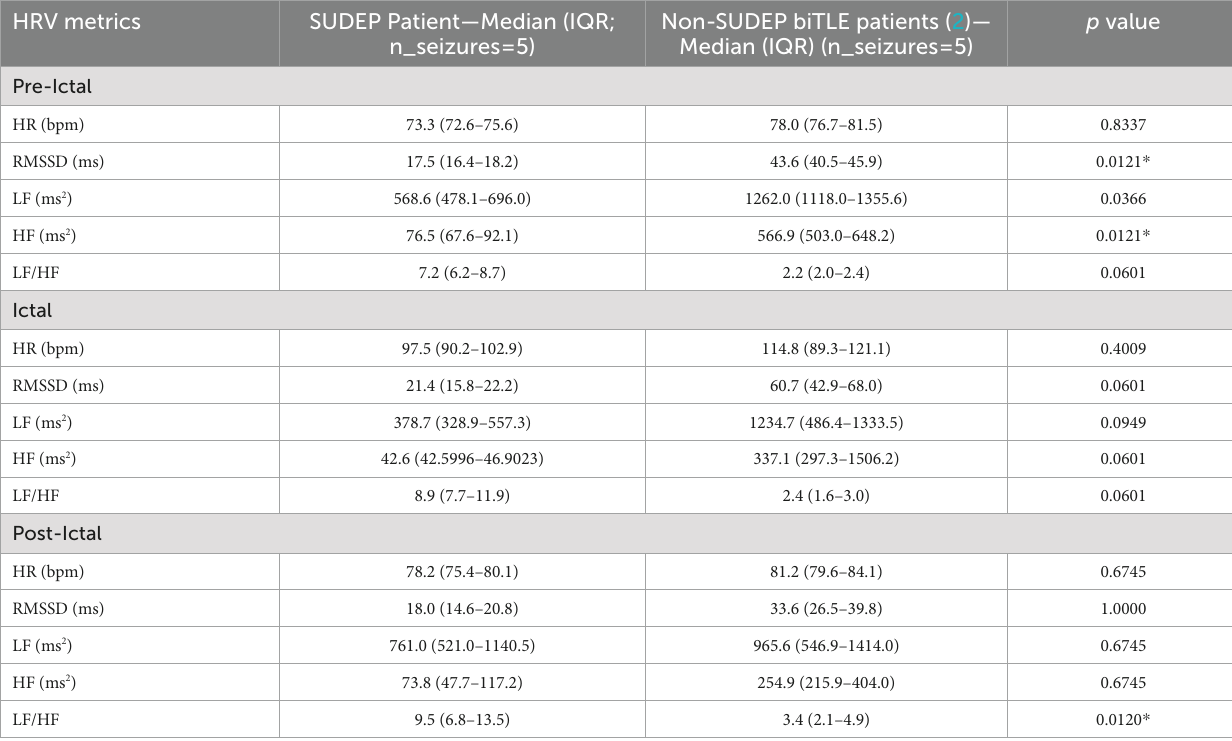
TABLE 2 Peri-ictal HRV analysis results. HRV metrics SUDEP Patient—Median (IQR;